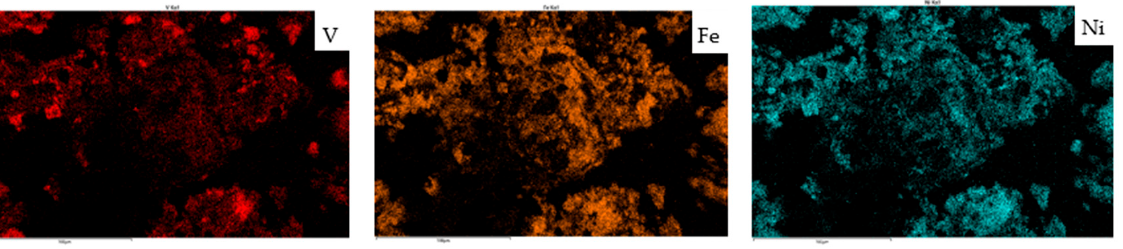
Figure 6. SEM-EDS spectra of petcoke ashed at 750 °C for V, Fe, Ni distribution.